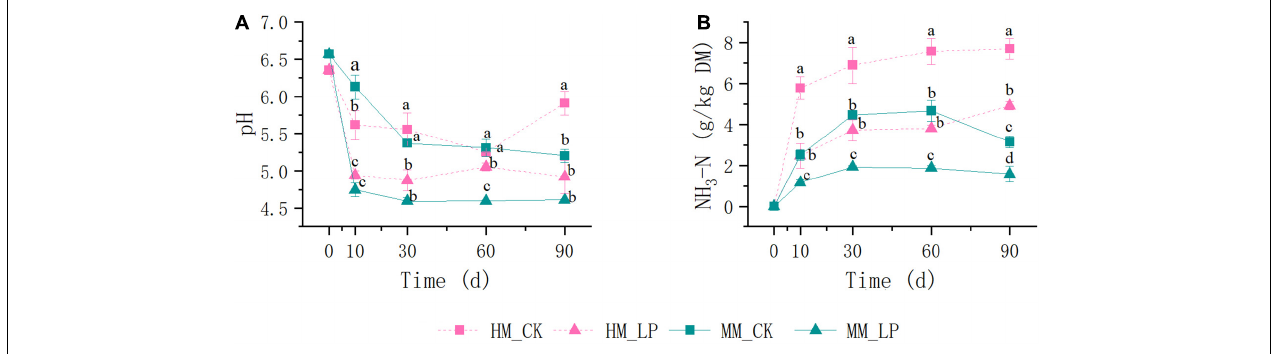
FIGURE 1 | Dynamics of pH (A) and NH 3 -N (B) concentration during ensiling. HM, not wilted before ensiling; MM, wilted before ensiling; CK, silage without inoculation; LP, silage inoculated with L. plantarum A345. Means with different small letters represents significant difference among treatments at the same